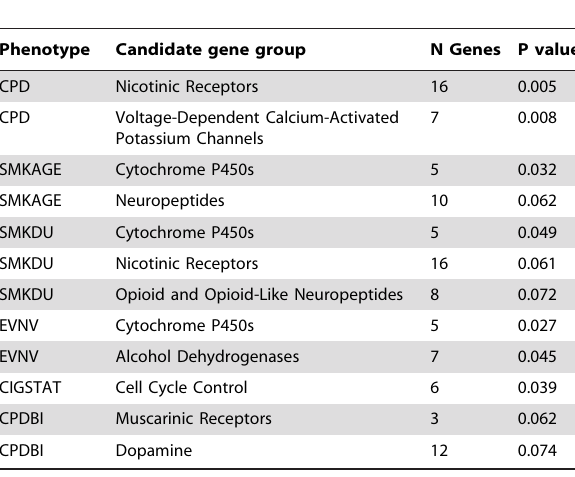
Table 4. Candidate Gene Groups with gene-level P ,